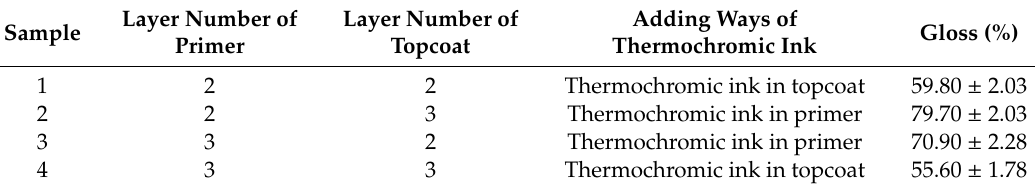
Table 6. Orthogonal experimental result of the influence of the coating process on the 60 ◦ gloss of coating.